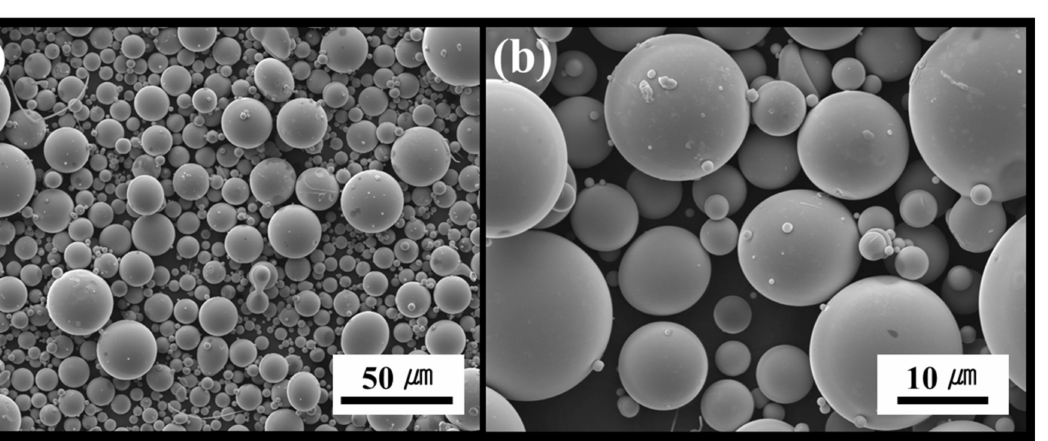
Figure 1. Particle morphology of the Ti-based BMG powder manufactured by electrode induction melting gas atomization. ( a ) 500 × magnification and ( b ) 2000 ×